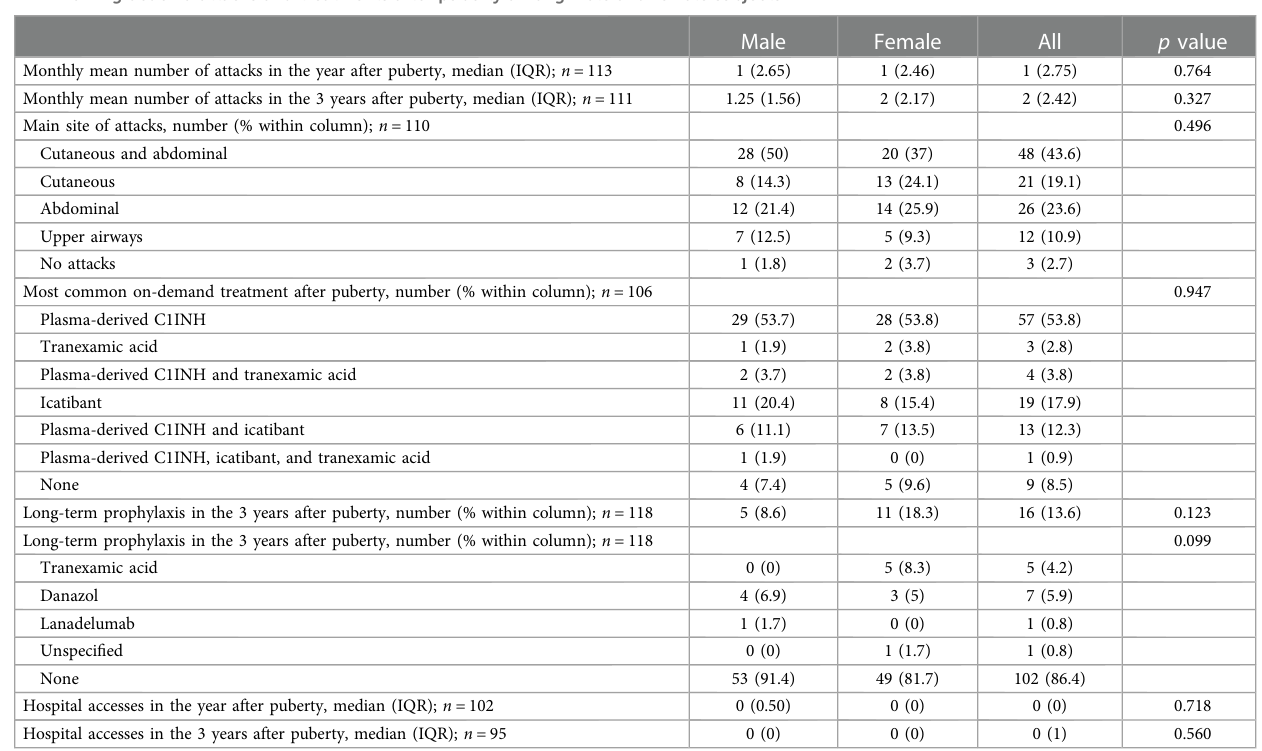
TABLE 3 Angioedema attacks and treatments after puberty among male and female subjects.